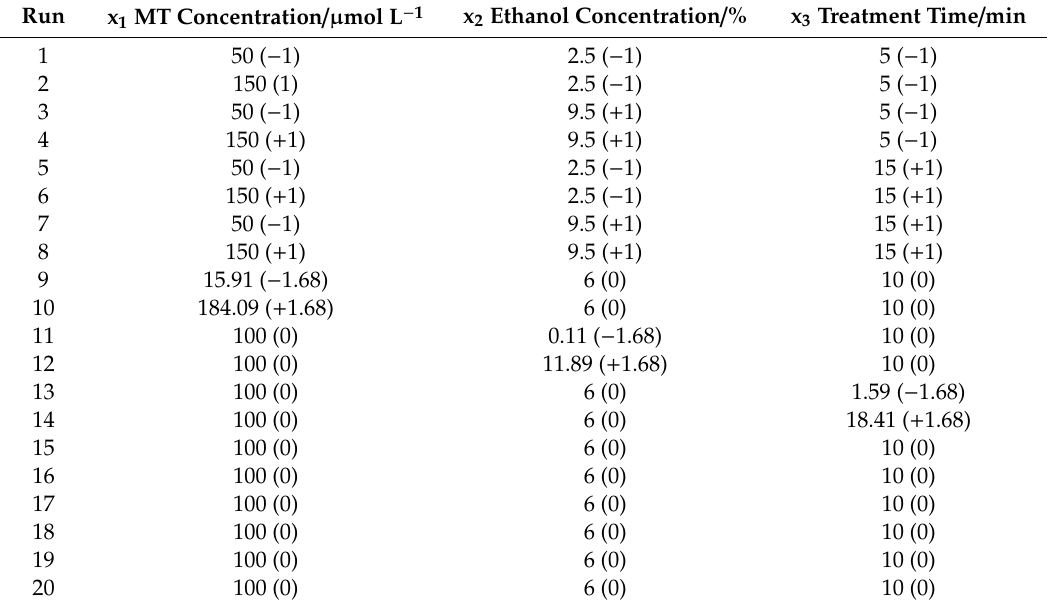
Table 1. Coded and actual level of independent variables for the central composite design